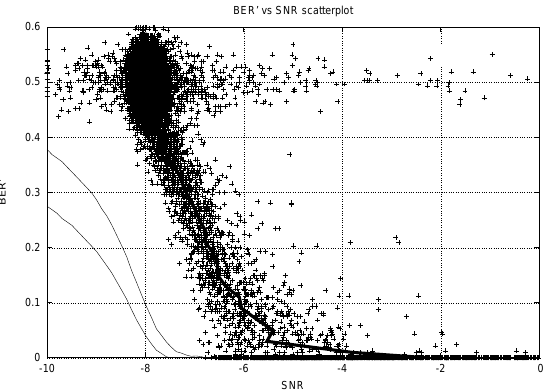
Figure 5. Experimental results using the following configuration: BW = 3125 Hz, 64-ary DS-SS, QPSK and rate 1/3 turbo coding. Every cross corresponds to a demodulated frame. A 3 dB loss of SNR is observed when comparing experimental and theoretical